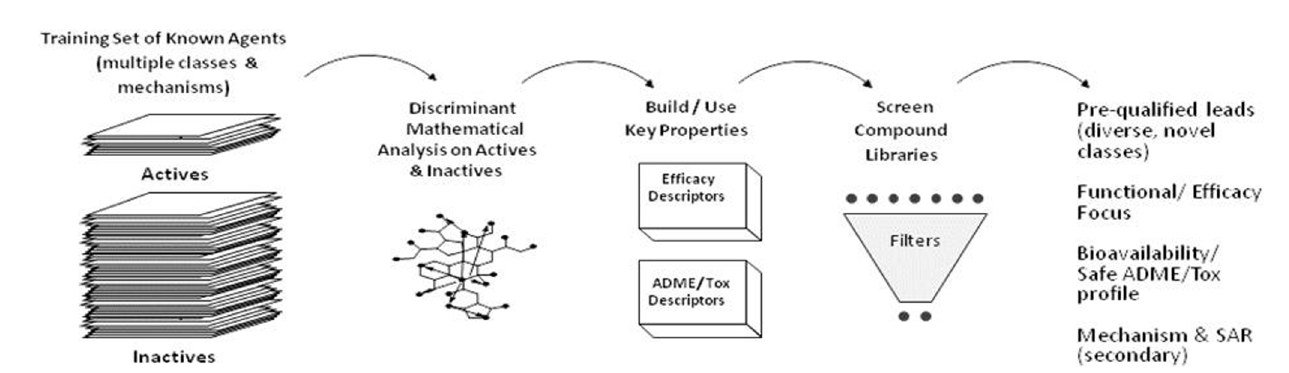
Figure 1. Forward Engineering process schematic. Each model iteration consists of five steps: (1) compilation of a training set of active and inactive compounds with associated data, (2) mathematical translation of structure into TIs, (3) use of TIs to develop model descriptors, (4) compound libraries are screened using the model filters to identify compounds that fit the desired properties, (5) selection of pre-qualified lead compounds for